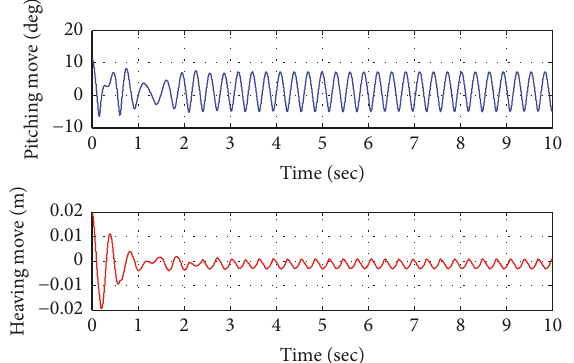
Figure 11: Results from [7] for a small two-dimensional wing with cycle-limited asymptotic oscillations.